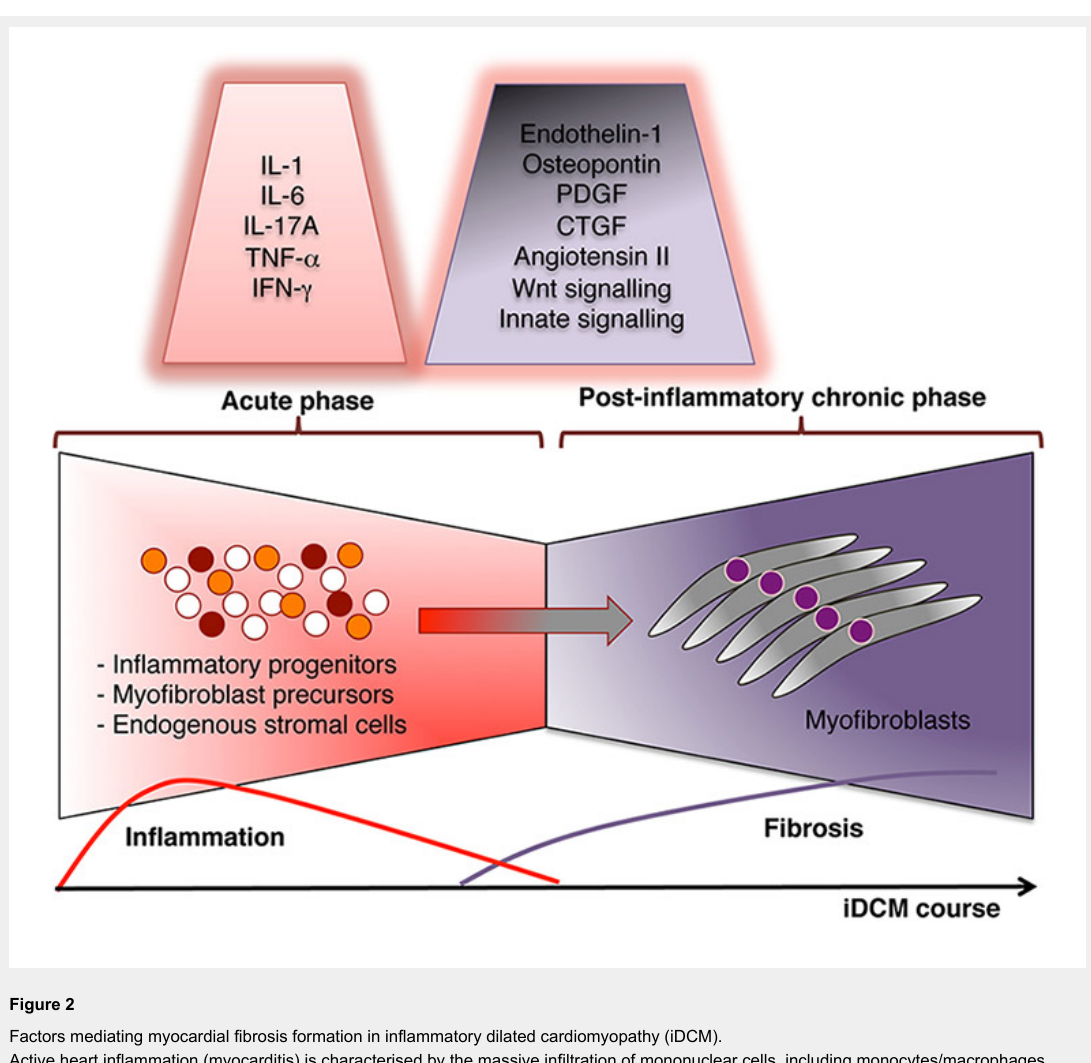
Figure 2 Factors mediating myocardial fibrosis formation in inflammatory dilated cardiomyopathy (iDCM). Active heart inflammation (myocarditis) is characterised by the massive infiltration of mononuclear cells, including monocytes/macrophages, granulocytes, T cells, dendritic cells, mast cells and cell progenitors. The inflammation slowly resolves and is replaced by fibrotic tissue. Postinflammatory tissue remodelling is a direct cause of heart failure in iDCM. Signalling orchestra modulates the transition from active myocarditis to iDCM. Tissue remodelling is associated with disruption of the highly organised myocardial extracellular matrix and excessive accumulation of collagen and collagen-producing myofibroblasts that leads to heart dysfunction. Mainly inflammatory progenitors and, to some extent, endogenous stromal cells or circulating myofibroblast precursors represent the cellular sources of myocardial myofibroblasts. The most potent factors mediating this specific transition from active myocarditis into iDCM are listed. CTGF = connective tissue growth factor; IFN = interferon; IL = interleukin; PDGF = platelet-derived growth factor; TNF = tumour necrosis